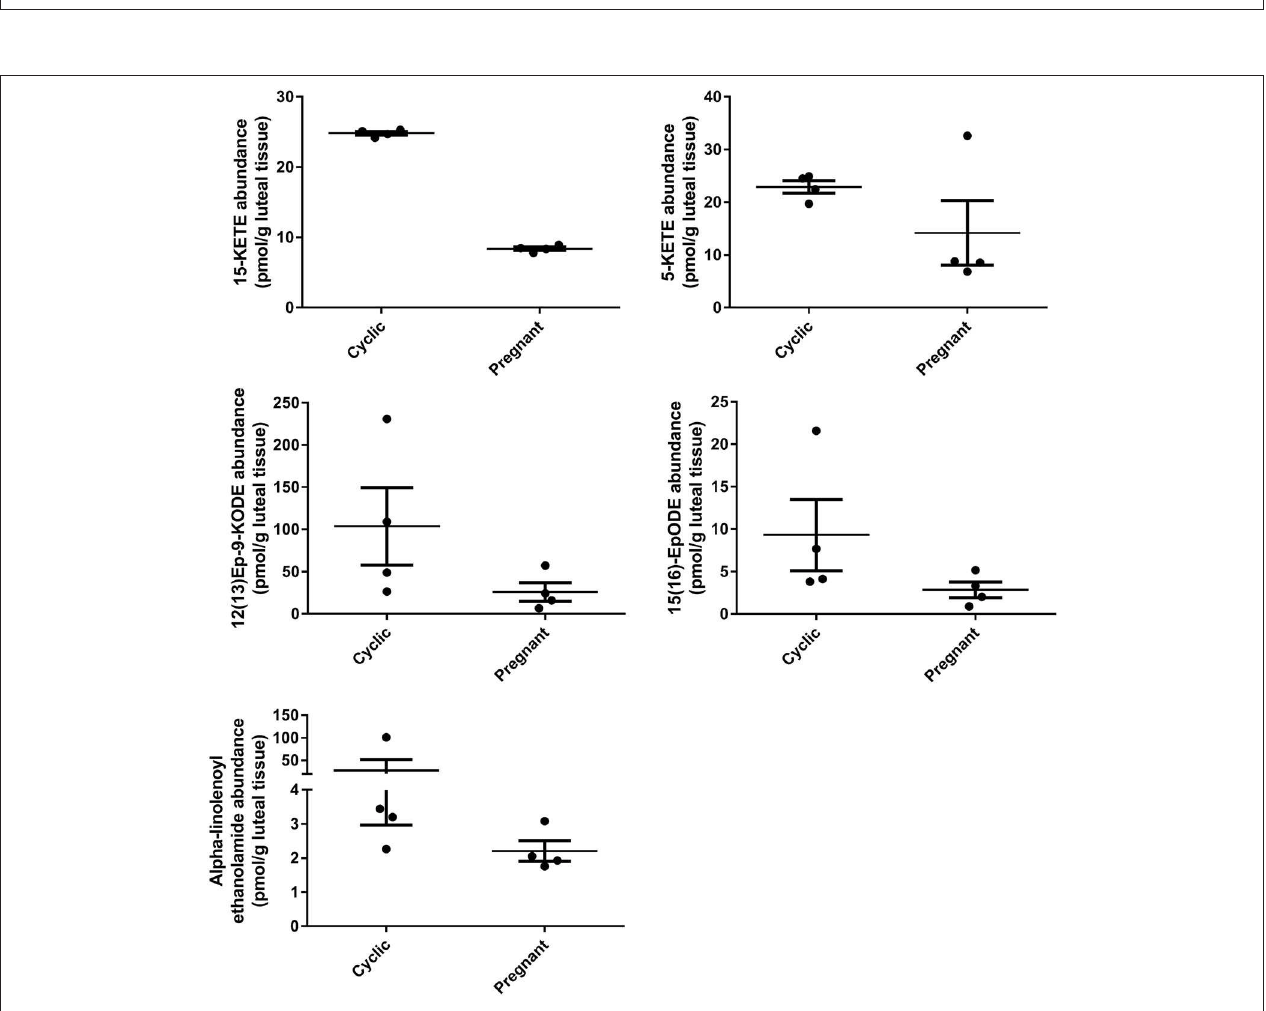
Frontiers in Endocrinology | www.frontiersin.org